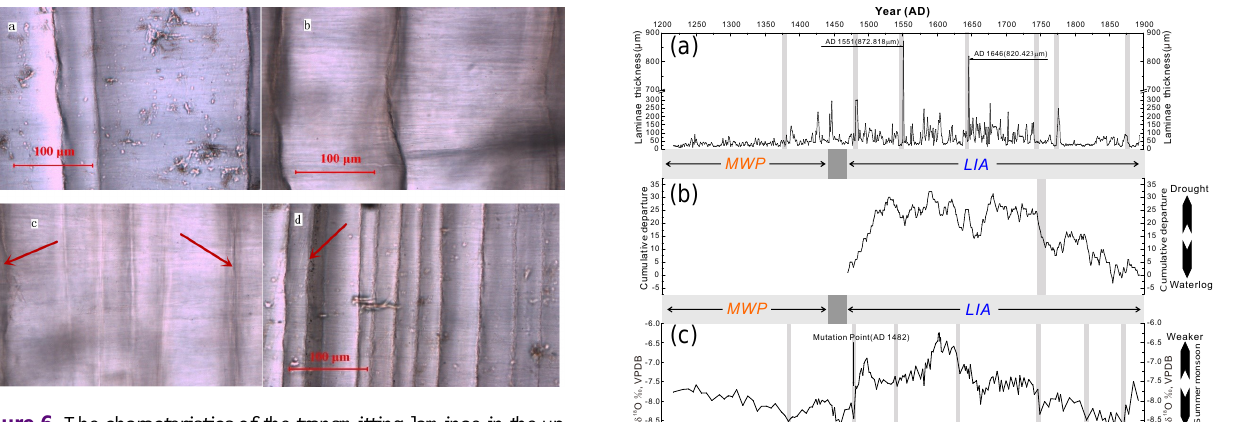
Figure 6. The characteristics of the transmitting laminae in the up- per part of stalagmite ky1 show that the thickness of the laminae has obvious variations. The boundary was curved, and the color near the boundary was deeper because of the dark transmitting laminae. The thickness of the laminae shows obvious variations (a) , the curve of the boundary of transmitting laminae (b) , the color variations of the boundary of transmitting laminae, the arrows indicating the darker boundaries, the boundaries in the middle were obviously whiter (c) , dark transmitting laminae (d) (the arrows indicated in the figure).